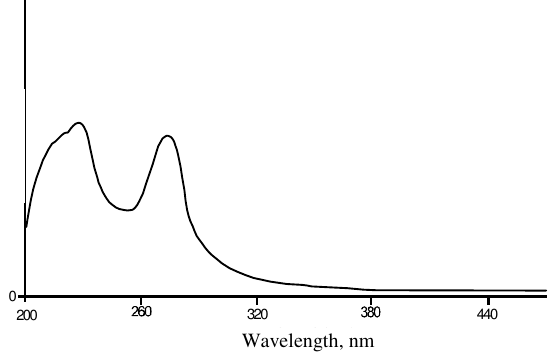
Figure 1. UV-visible spectra of p -CDF terpolymer resin